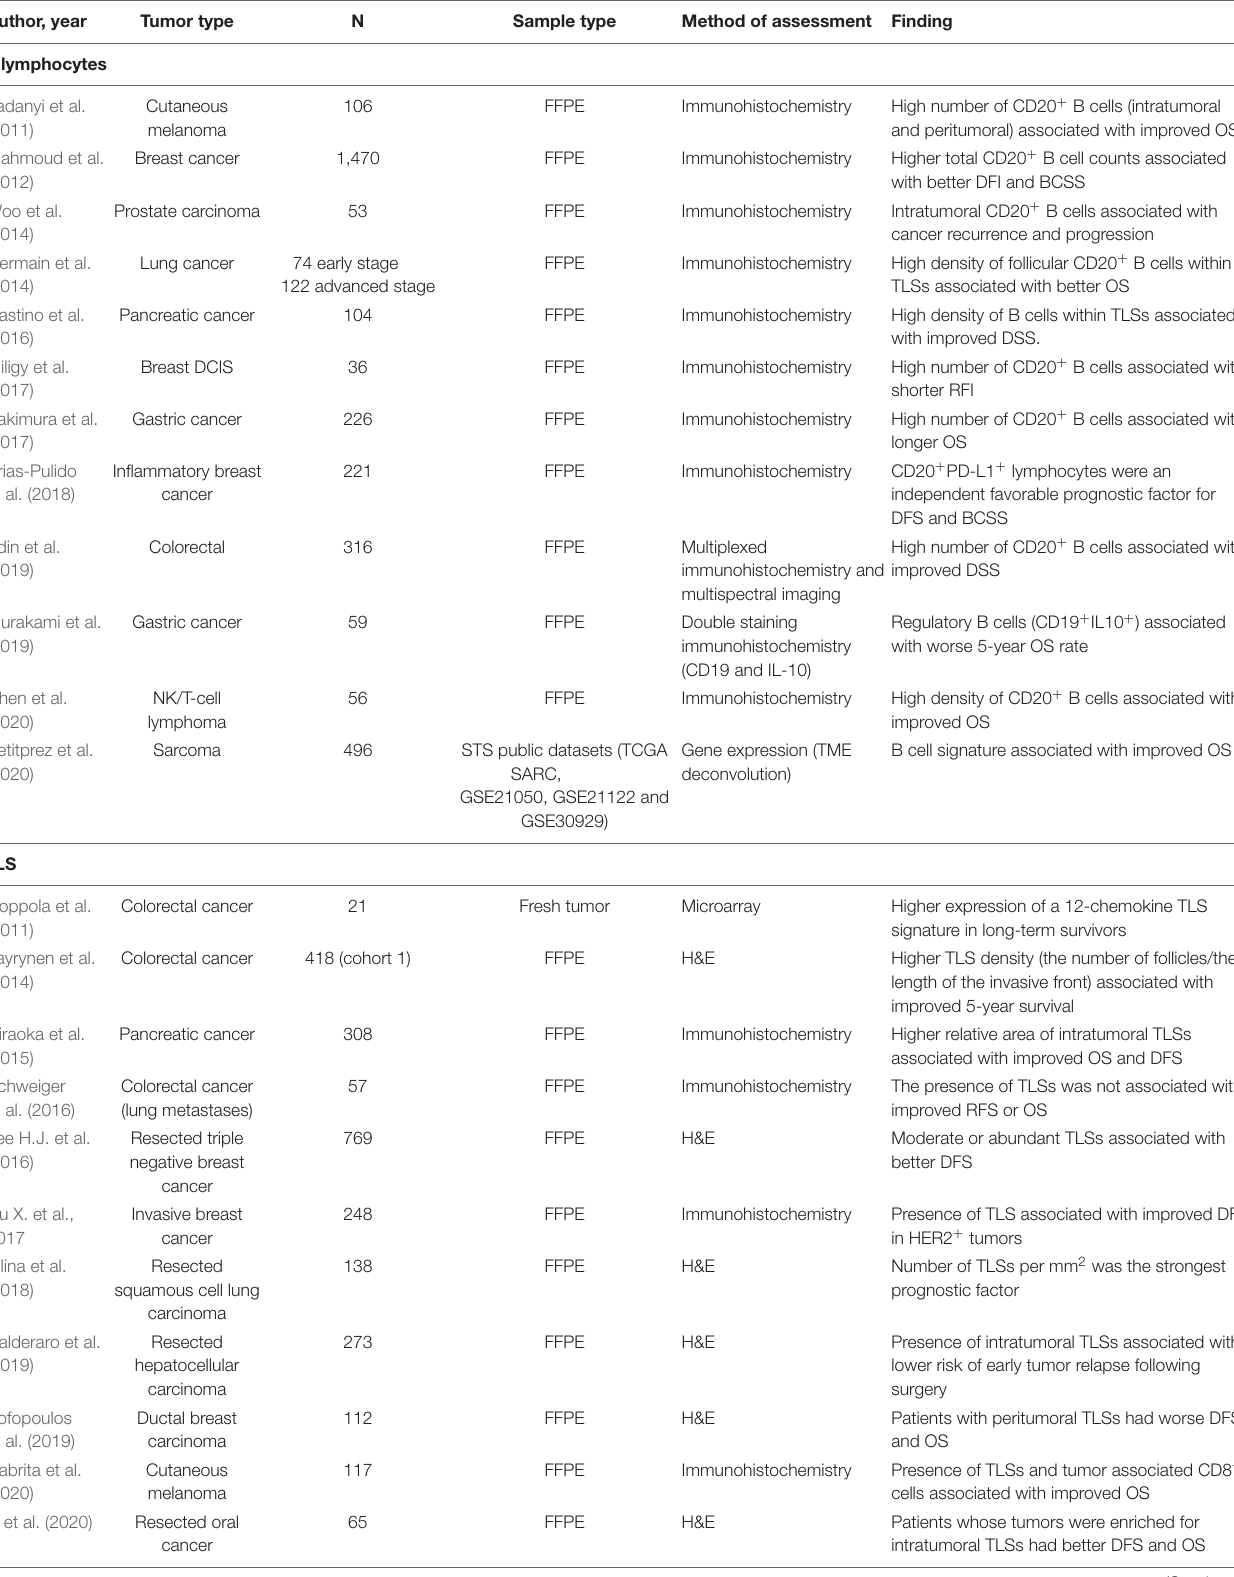
TABLE 1 | B cell and TLS presence and abundance as prognostic factors in different